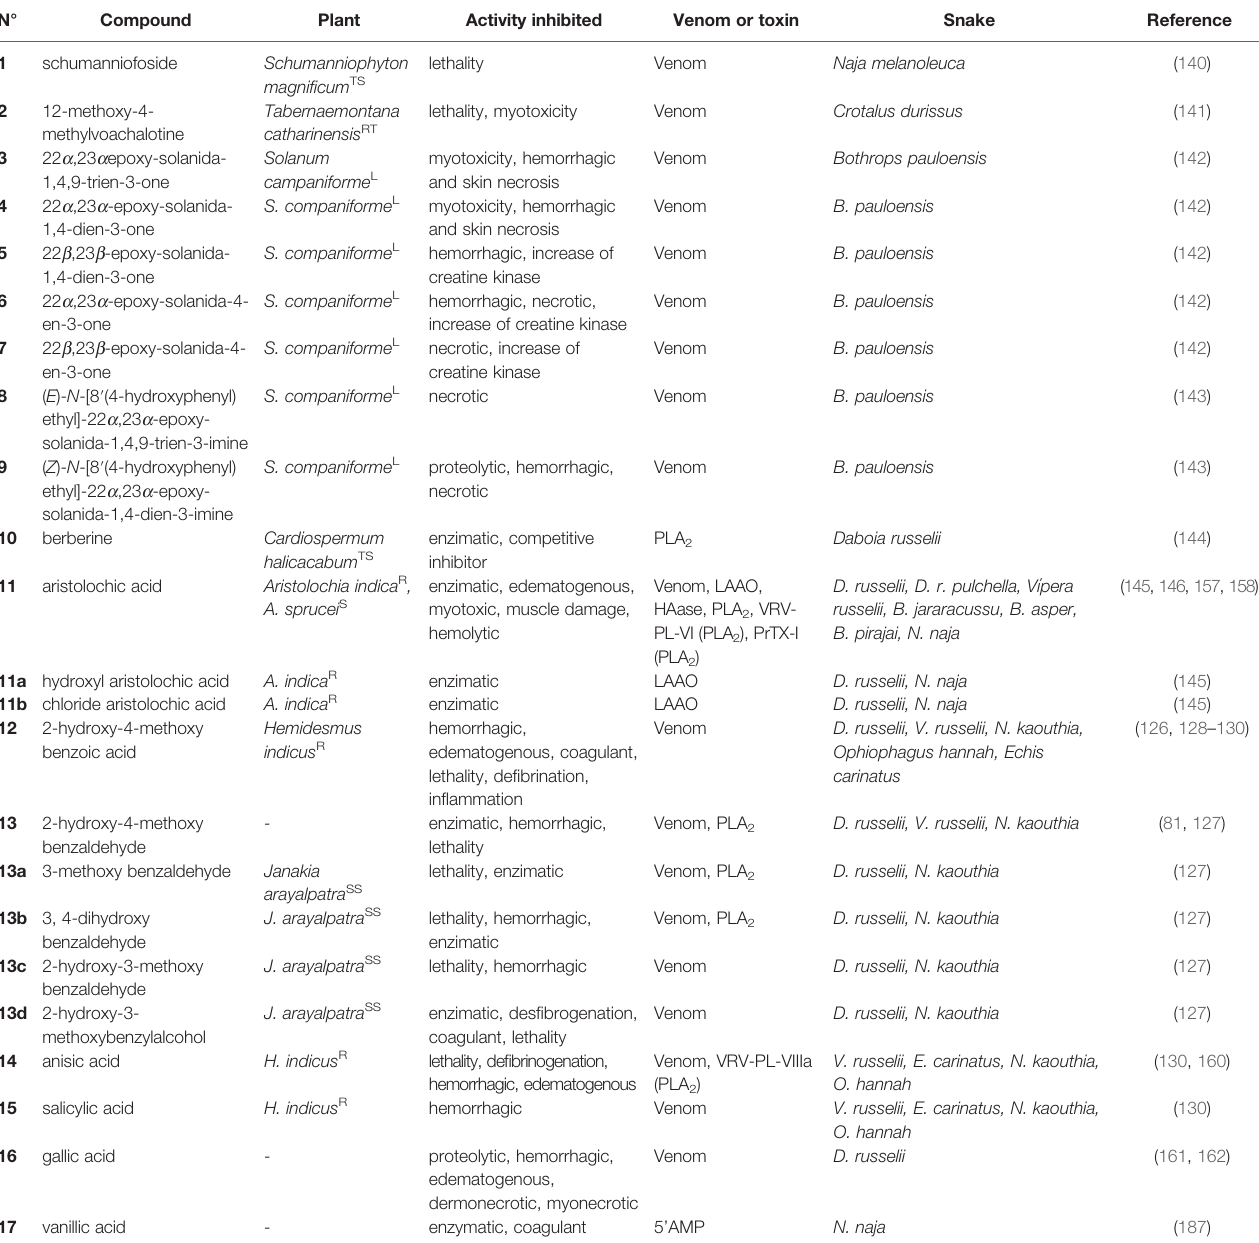
TABLE 1 | Alkaloids (1 – 11) and benzenoids (12 – 17) with antivenom